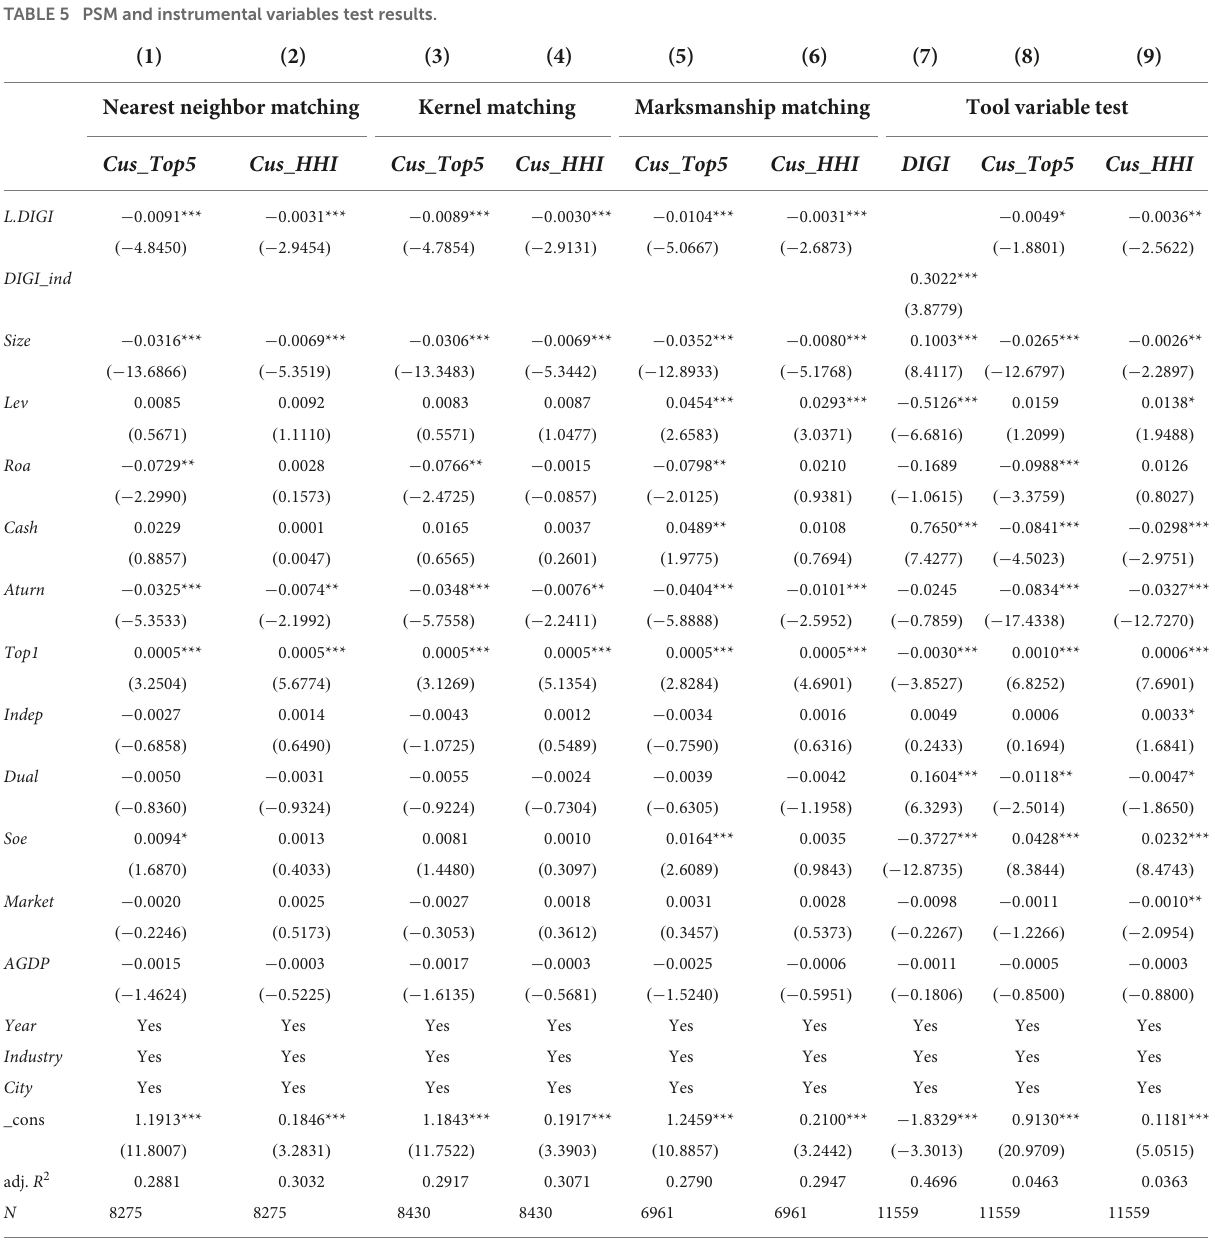
TABLE 5 PSM and instrumental variables test